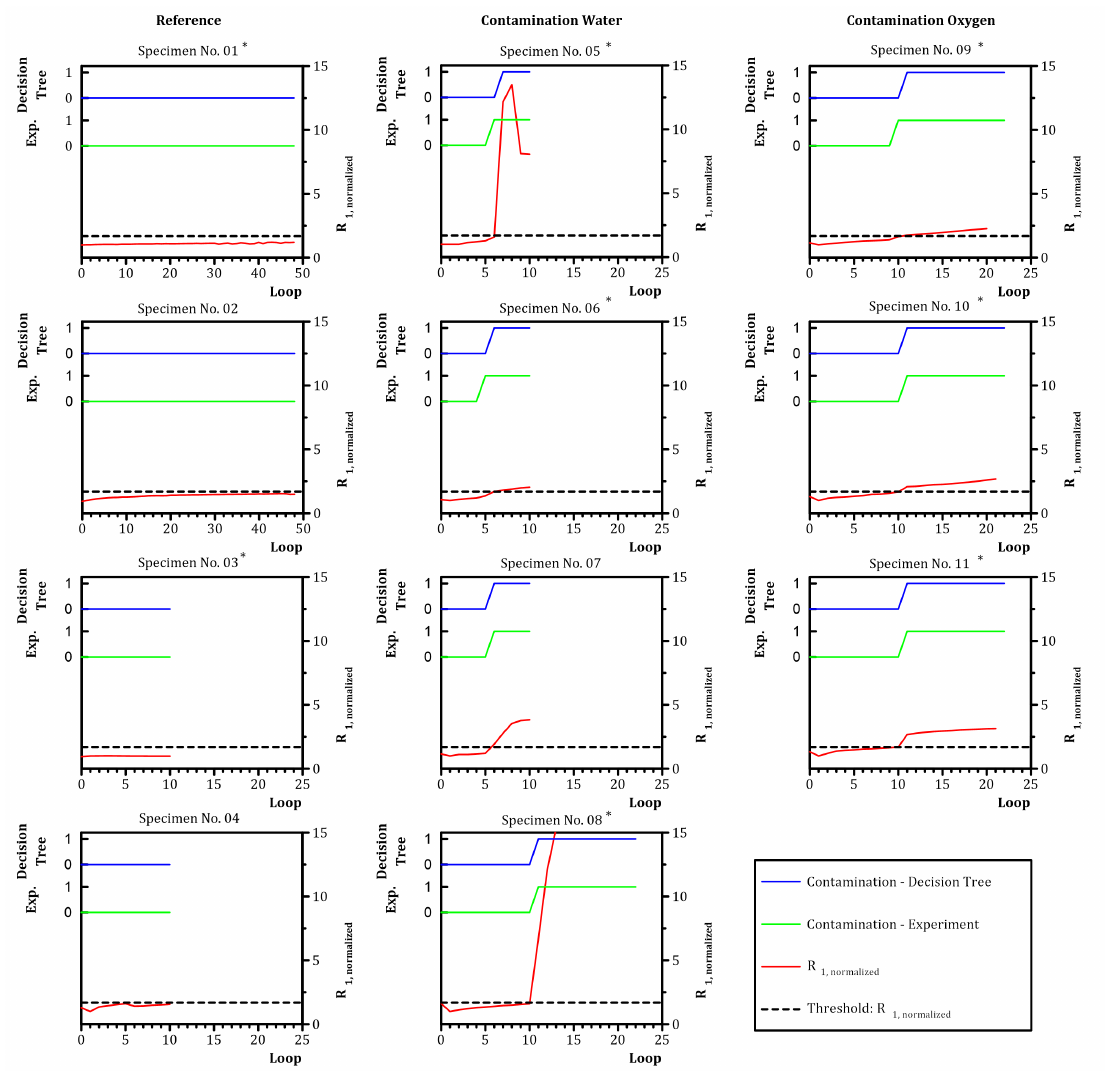
Figure 8. Prediction of classes “no contamination” (0) and “contamination” (1) with a decision tree of depth = 1 based on R 1, normalized . Blue—decision tree; green—experiment. * Training data—data set was used as training data for the decision